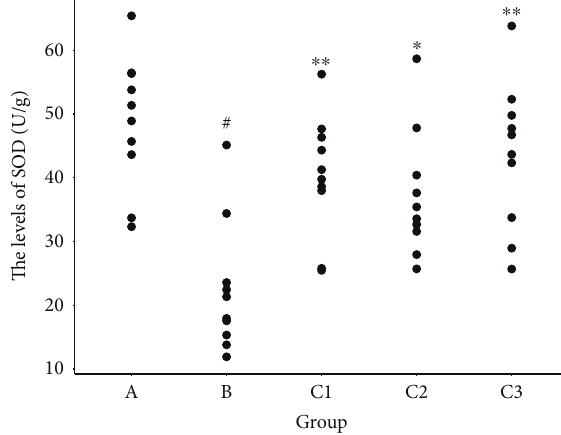
Figure 7: Changes in the levels of SOD in mice cerebral tissue homogenates. # P < 0 01 versus group A; ∗ P < 0 05 , ∗∗ P < 0 01 versus group B. Data are presented as the mean ± standard deviation; n = 10 . MDA: malondialdehyde; SOD: superoxide dismutase; group A: sham-operated; group B: control; group C1: pretreatment; group C2: treatment; group C3: pretreatment +